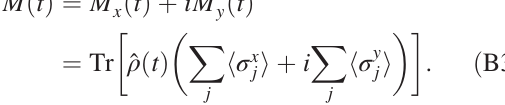
TABLE I. The standard deviations of h and numerical simulations when